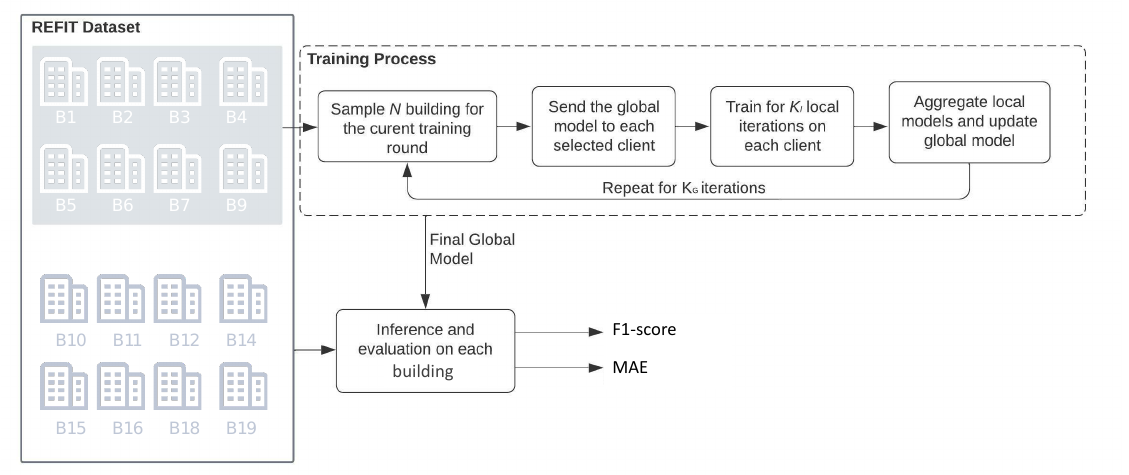
Figure 5. Flowchart of the simulated